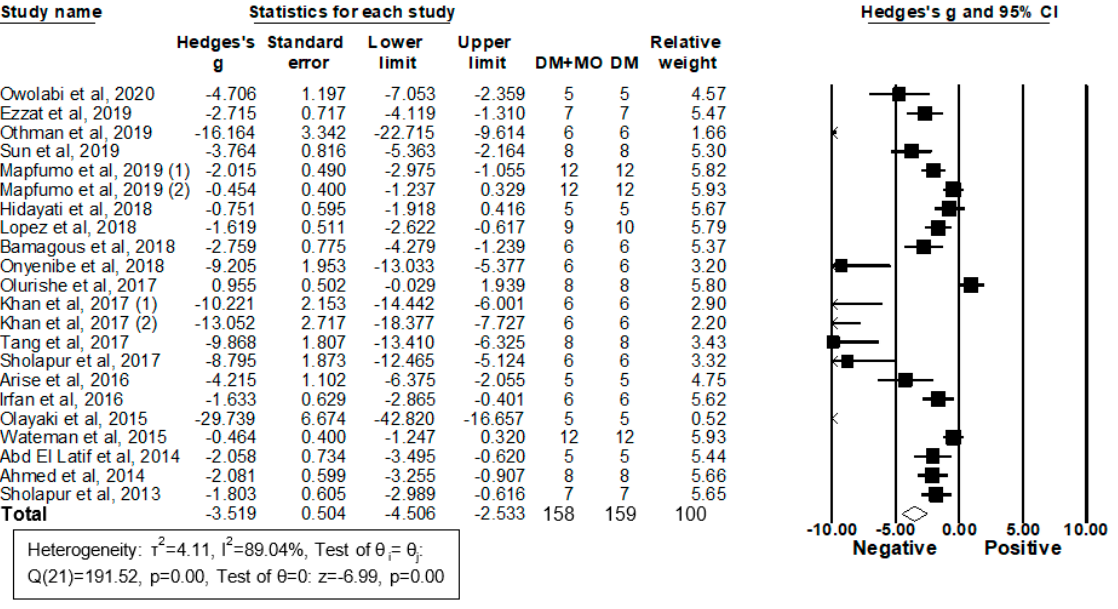
Figure 5. Meta-analysis of Hedges’ g of triglyceride levels in DM rodents with and without treatment with MO. Summary estimates were analyzed using a random-effects model. CI, confidence interval.